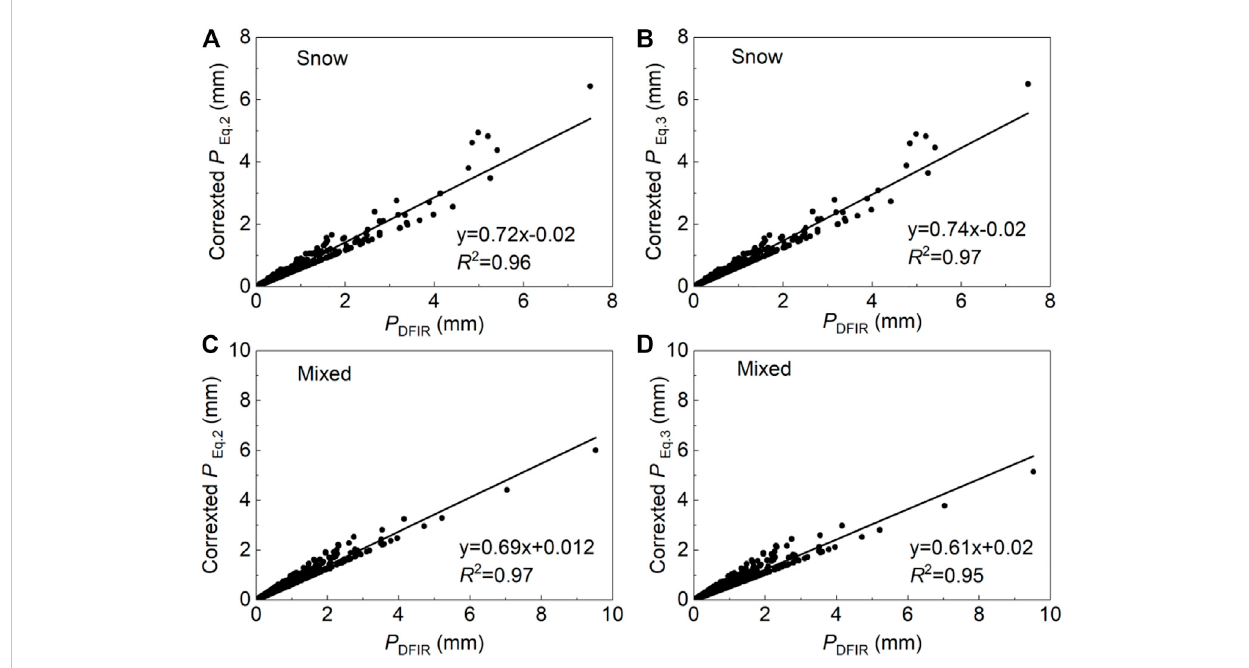
FIGURE 6 Comparison of corrected snow (A , B) and mixed precipitation (C , D) using Eqs 2, 3 with the precipitation derived from the DFIR.